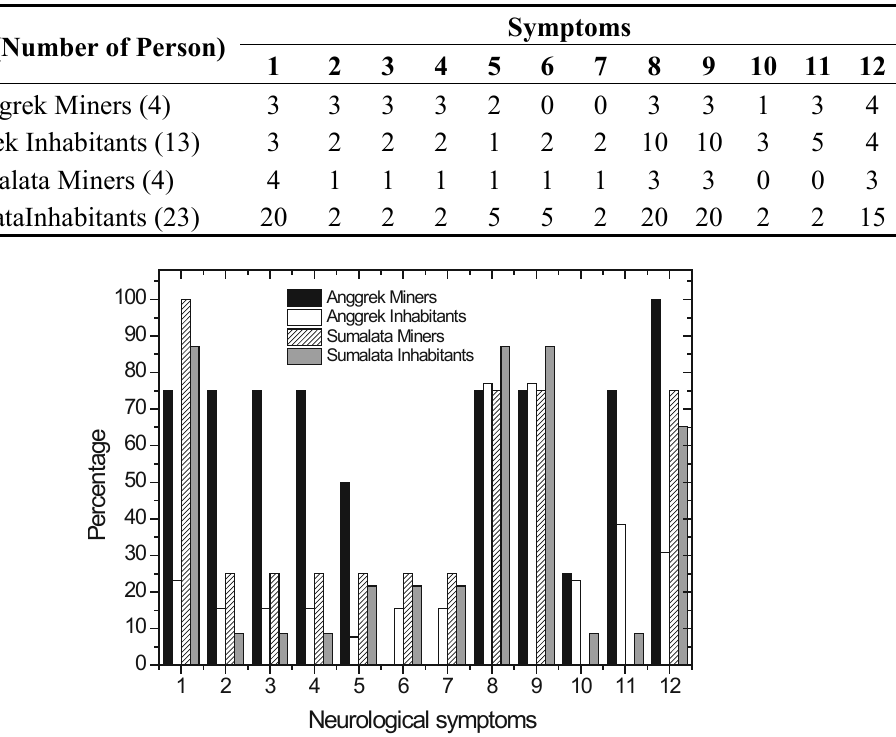
Table 3. Objective symptoms observed of the participants.